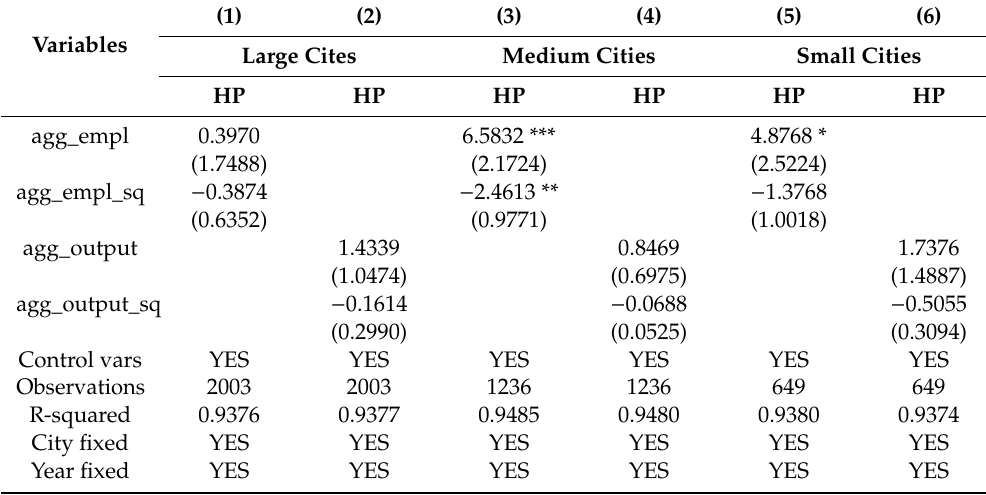
Table 5. Heterogeneous analysis—city